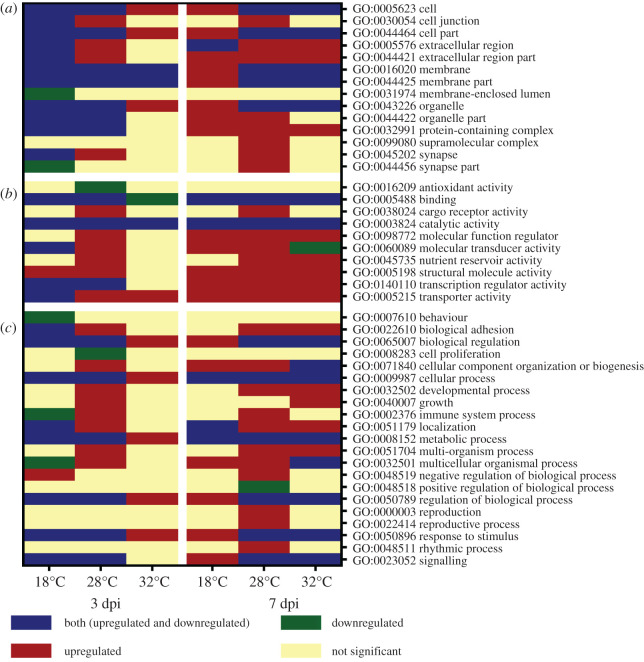
Gene Ontology analysis of differentially expressed genes (DEGs) in CHIKV-infected Ae. aegypti mosquitoes, held at three temperatures and sampled at two time points post infection (dpi). (a) Cellular locations; (b) molecular functions; (c) biological processes.